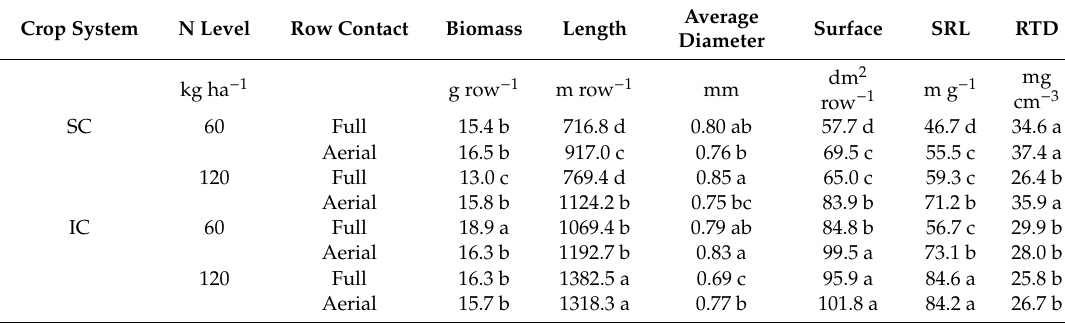
Table 4. Lateral root parameters, Specific Root Length (SRL) and Root Tissue Density (RTD) of field bean, as a ff ected by the Crop system × N level × Row contact interaction. SC, sole crop; IC, intercrop. For each parameter, values followed by the same letter within a column are not significantly di ff erent at P < 0.05, Tukey’s test.